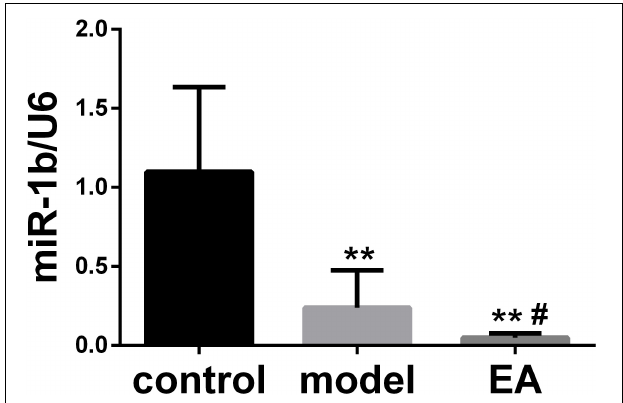
FIGURE 1 | Electroacupuncture (EA) downregulated the expression of miR-1b in the injured sciatic nerve. The expression of miR-1b was detected by quantitative real-time RT-PCR (qRT-PCR). ** P < 0.01 versus the control group; # P < 0.05 versus the model